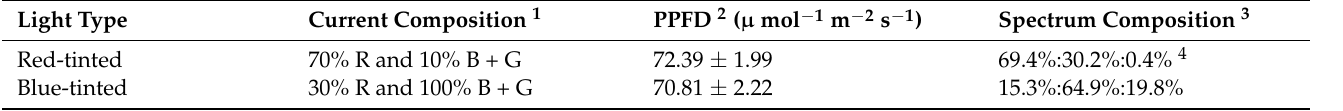
Table 1. Properties of contrasting lights (red-color-tinted vs. blue-color-tinted) in light emitting diodes (LEDs) for the culture of black chokeberry ( Aronia melanocarpa (Michx.) Elliott 1821) seedlings in a greenhouse.